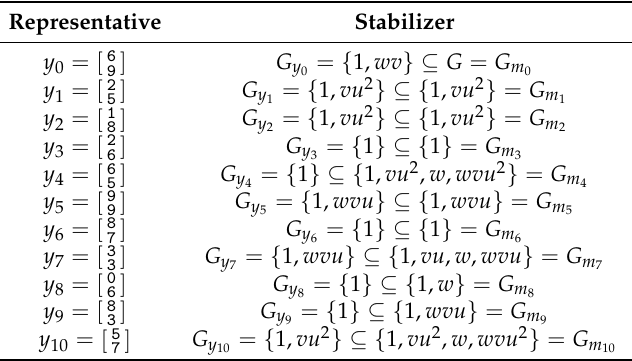
Table A10. Representatives in heading space Z 2